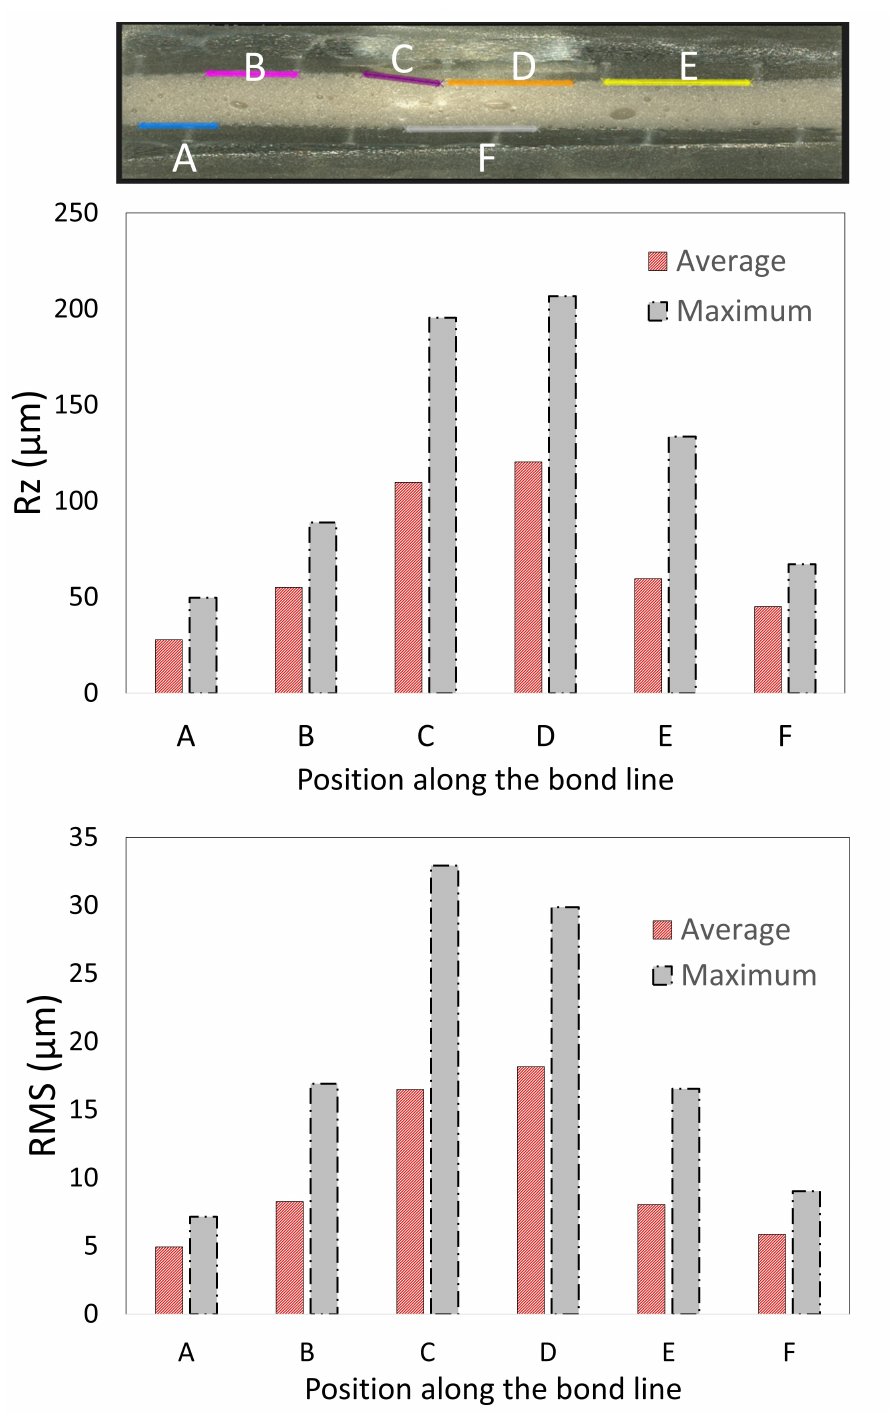
Figure 23. Comparison of surface roughness along the bondline interface for joint with a bondline thickness of 0.6 mm subjected to an impact energy of 15